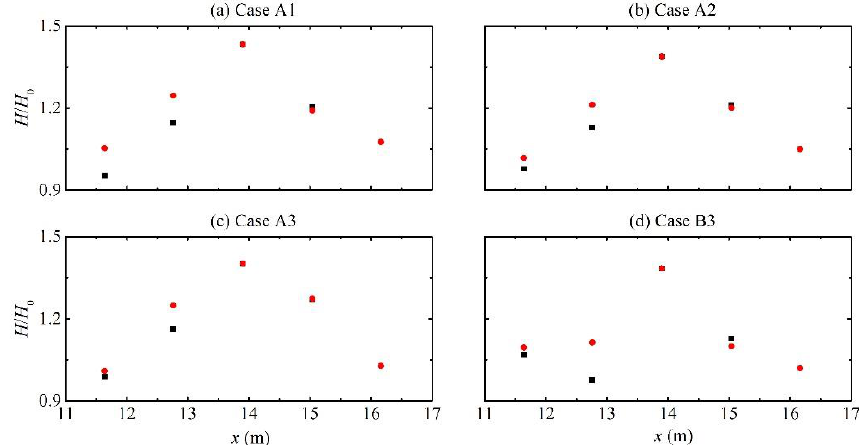
Figure 4. Wave height along the centerlines of the two channels in the interaction region for cases with f = 0.8 Hz. The red circles represent the wave heights measured on the extension line of the A flume, and the squares represent that on the extension line of the B